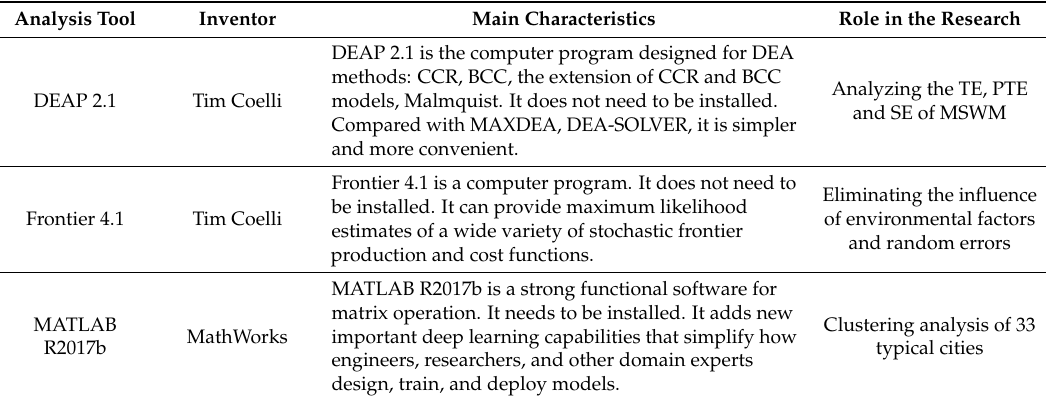
Table 4. Analysis tools used in the